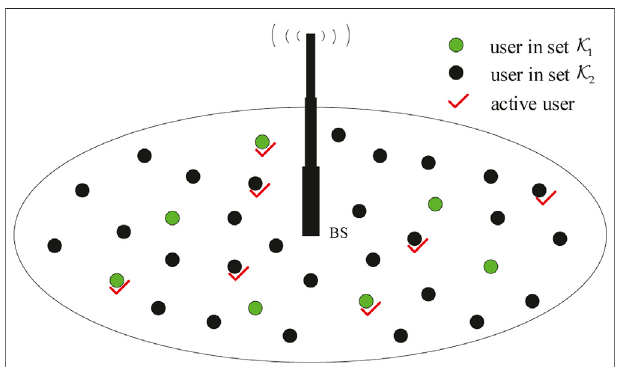
FIGURE 1 | Uplink mMTC system. All users are divided into two classes with sets K 1 and K 2 . Users in K 1 transmit both user-speci fi c and common information, and users in K 2 transmit only common information. Moreover, only part of users in both classes is active due to the sporadic transmission